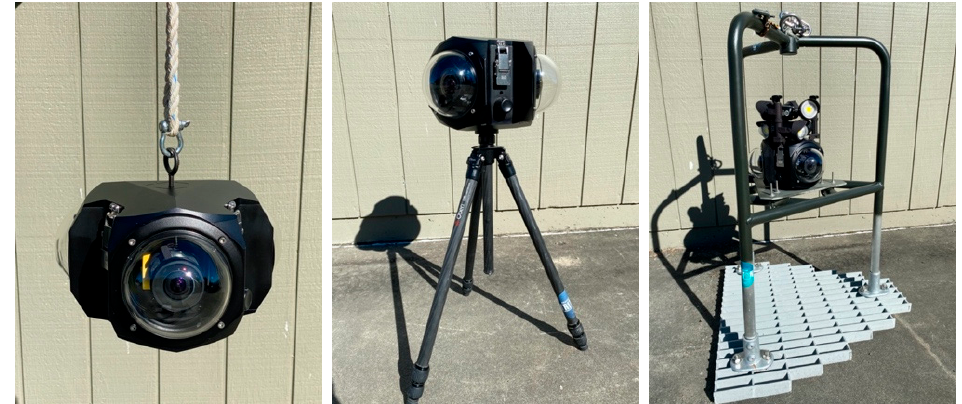
Figure 2. Boxfish in the different configurations: from left to right , hand-held, mounted on tripod, and mounted on lander with external lights on top of the camera.